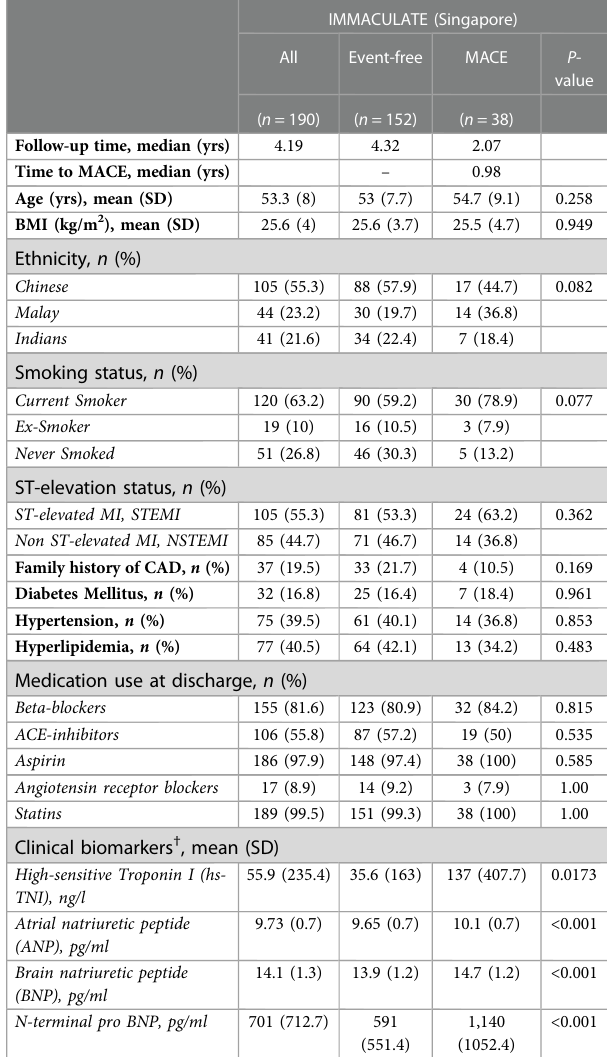
IMMACULATE (Singapore)